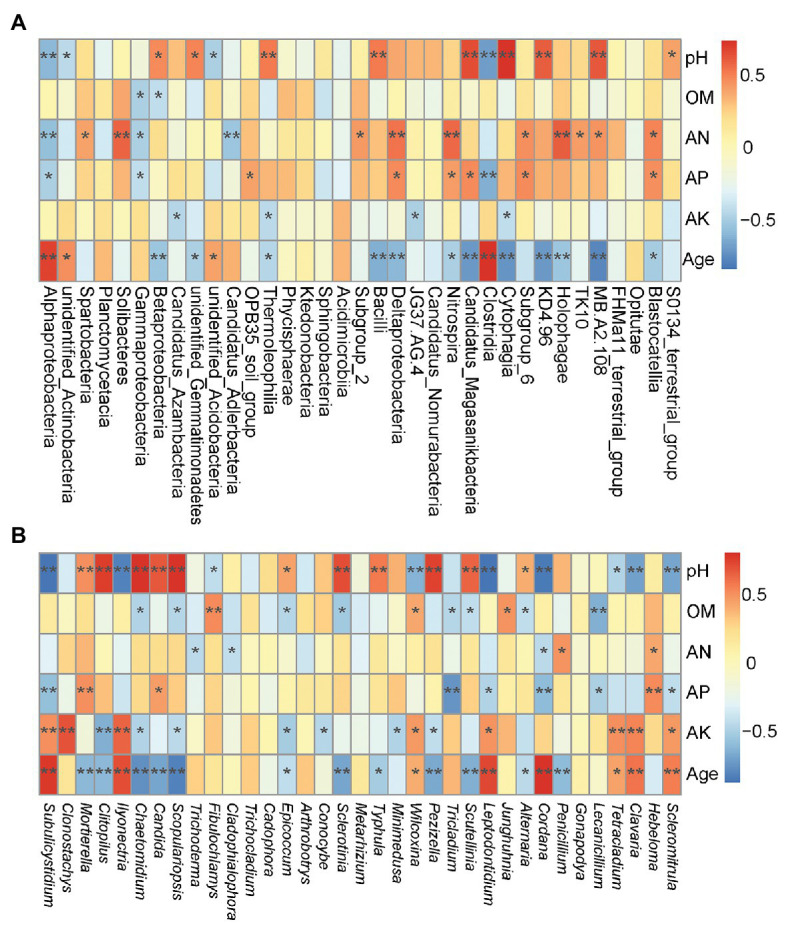
Spearman’s correlation analyses between the soil properties and plant age, and abundance of the top 35 bacterial classes (A) and fungal genera (B). **
p < 0.01; *
p < 0.05. OM, organic matter; AN, available nitrogen; AP, available phosphorous; and AK, available potassium.